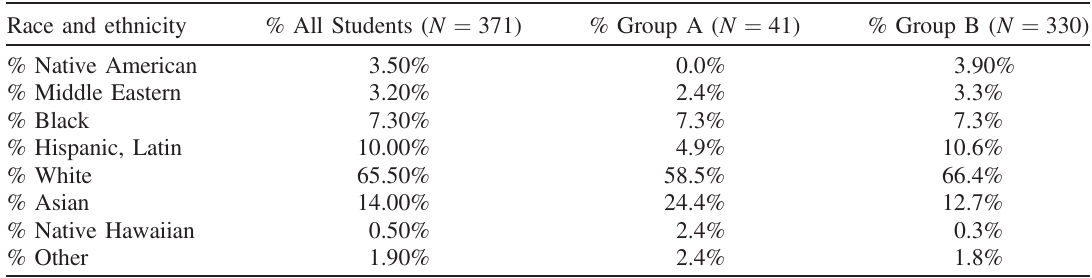
TABLE III. Demographic comparison between demographics of sample, group A and B. Race and